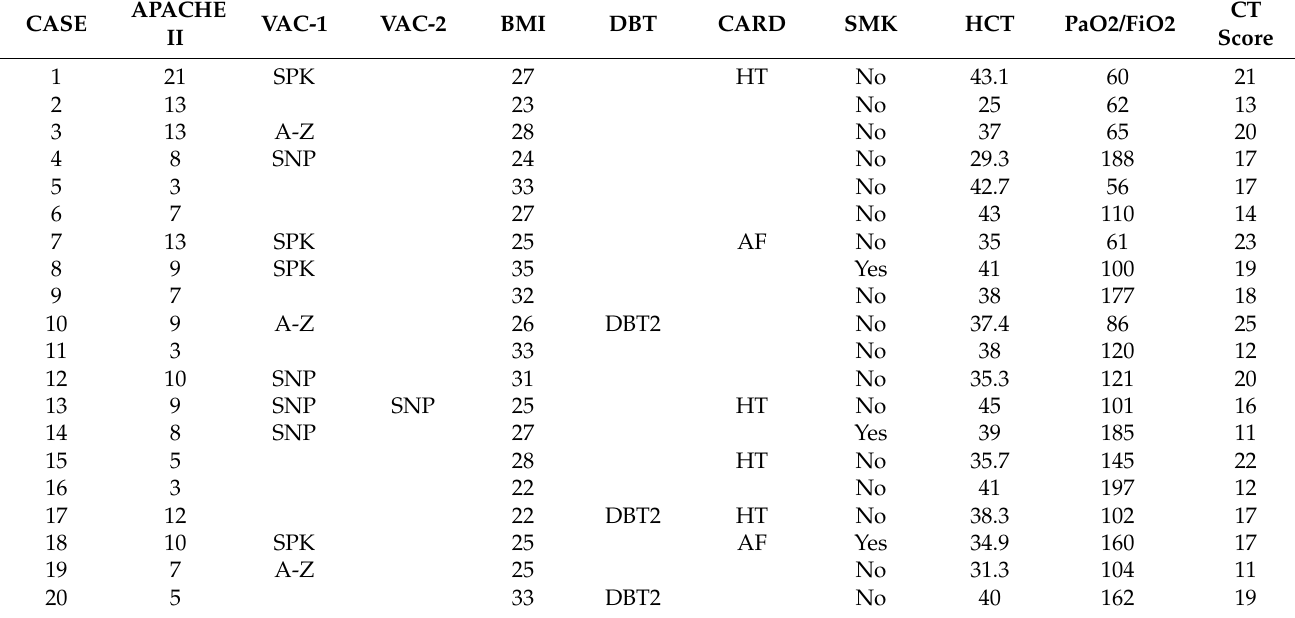
Table 1. Demographic data and background. Hematocrit, Pao2Fio2, and CT score at admission of the 20 cases. CASE